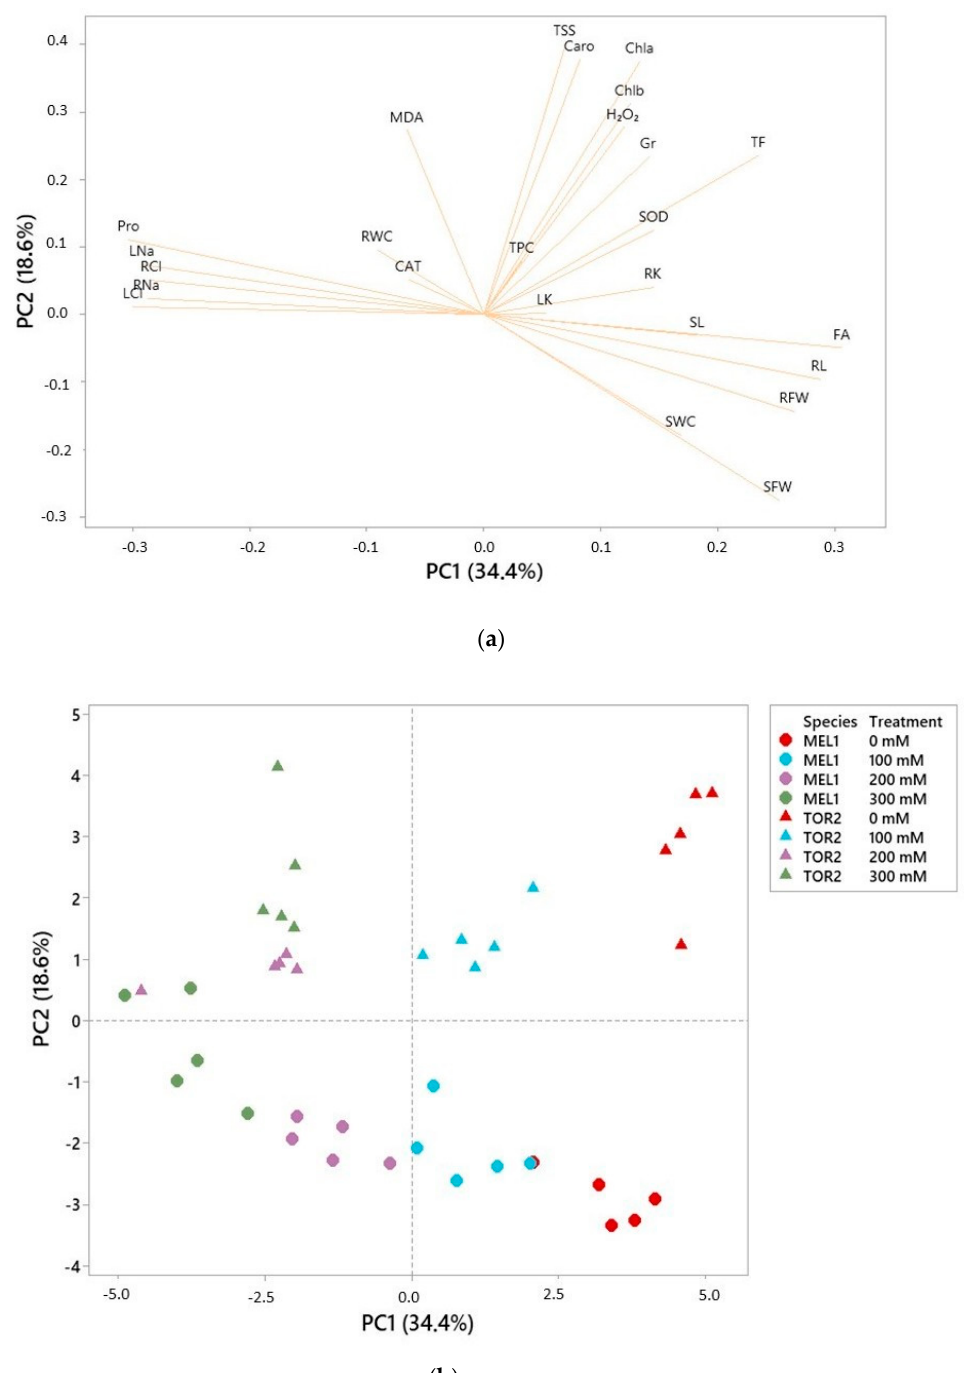
Figure 3. Loading plot of the principal component analysis (PCA) (a), and scatterplot of the PCA scores (b), including all analyzed traits in Solanum melongena and S. torvum plants subjected for 25 days to NaCl treatments, as indicated. The first and second principal components account for 38.6% and 19.1% of the total variation, respectively. Abbreviations: shoot fresh weight (SFW), shoot water content (SWC), maximum foliar area (FA), shoot length (SL), root fresh weight (RFW), root water content (RWC), root length (RL), chlorophyll a (Chl a), chlorophyll b (Chl b), carotenoids (Caro), Na + content in leaves (LNa), K + content in leaves (LK), Cl − content in leaves (LCl), Na + content in roots (RNa), K + content in roots (RK), Cl − content in roots (RCl), proline (Pro), total soluble sugars (TSS), malondialdehyde (MDA), total phenolic compounds (TPC), total flavonoids